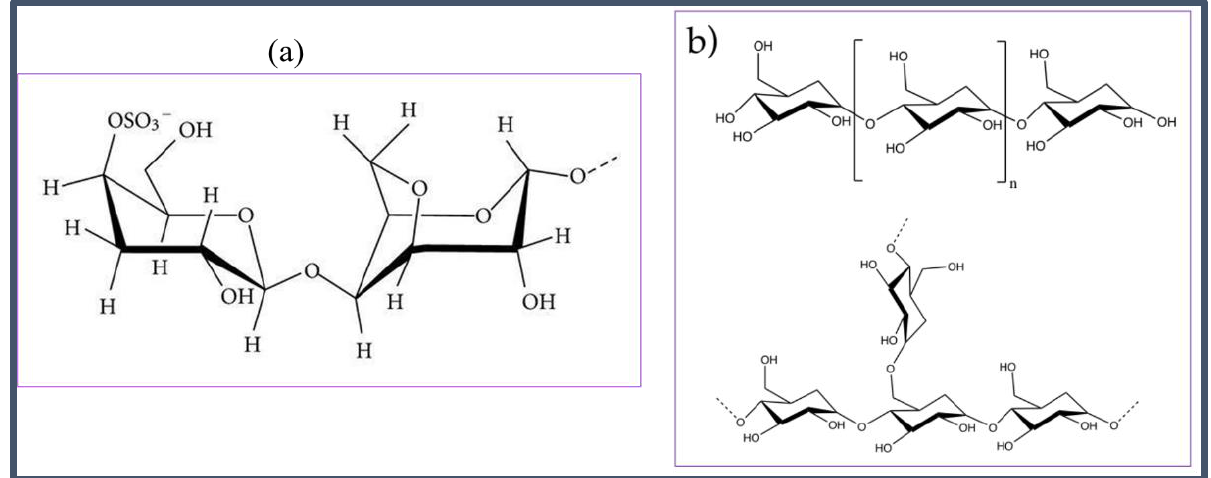
Scheme 1. Chemical structure of κ -carrageenan ( a ) and starch ( b ).